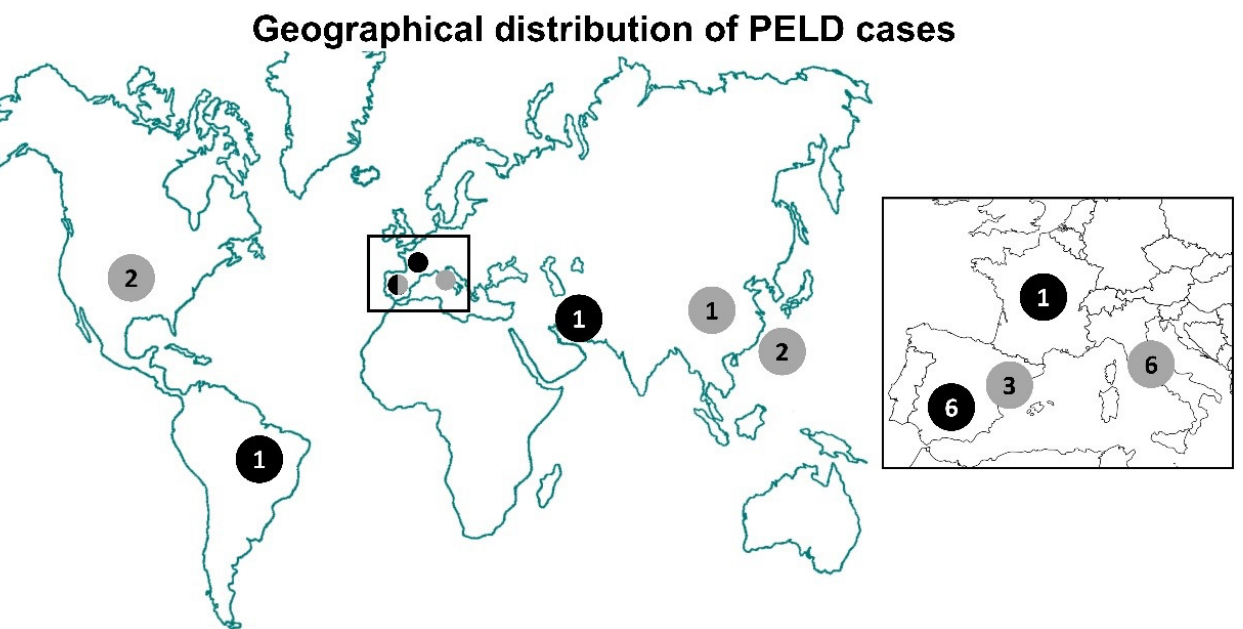
Figure 1. Worldwide distribution of BSCL2 progressive encephalopathy with or without lipodystrophy. Black circles: Homozygous or compound heterozygous patients for c.985C>T variant; gray circles: Patients with other variants in BSCL2 . The numbers inside the circles indicate the number of cases per country referred to in Table 1: Spain: Cases #1 to #6, #10, #22, and #23; Italy: Cases #12 to #14 and #19 to #21; USA: Cases #11 and #18; Taiwan: Cases #16 and #17; Brazil: Case